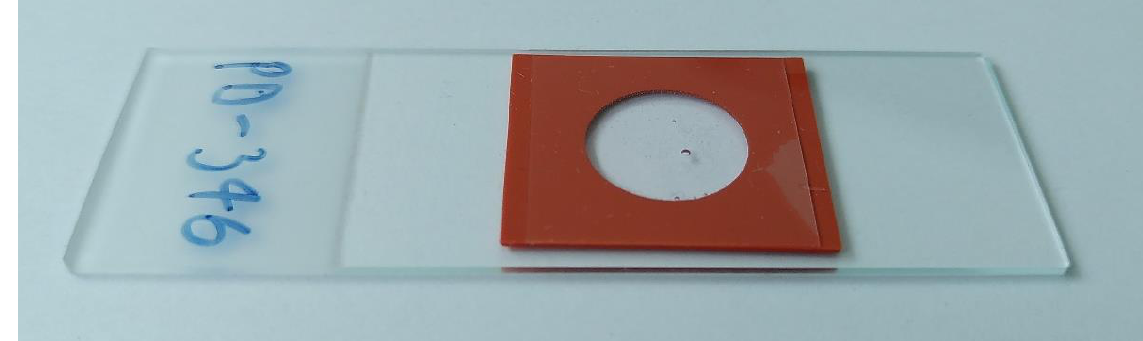
Figure A2. Slide with rubber spacer and cover slip.